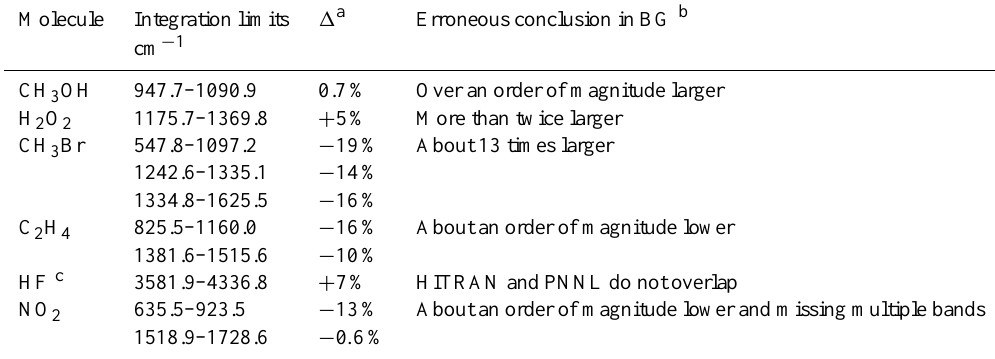
HITRAN and PNNL do not